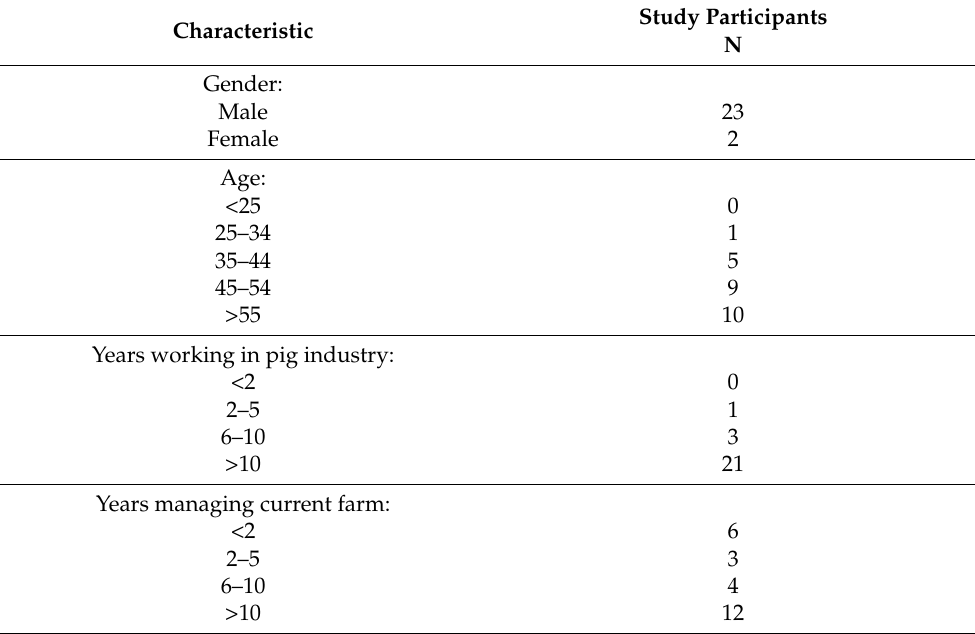
Table A1. Demographics of the 25 pig farm managers who participated in the